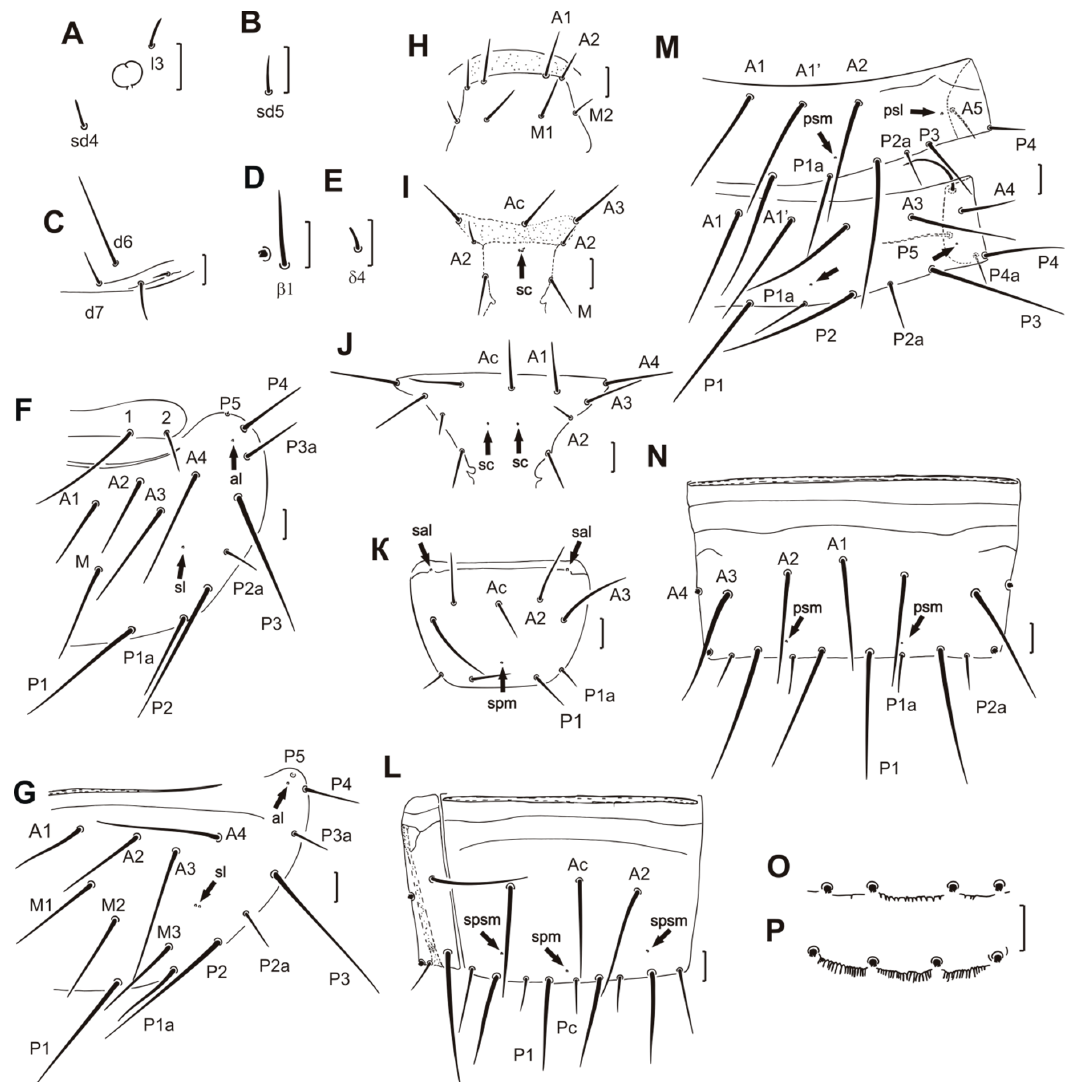
Figure 2. Mastodonentomon macleani (Nosek, 1977). ( A ) Pseudoculus with setae l3 and sd4 . ( B ) Cephalic seta sd 5. ( C ) Hind part of head. ( D ) Foretarsal seta β 1 . ( E ) Foretarsal seta γ 4 . ( F ) Pronotum and mesonotum, right side. ( G ) Metanotum, right side. ( H ) Anterior part of the prosternum. ( I ) Anterior part of the mesosternum. ( J ) Anterior part of the metasternum. ( K ) Sternite I. ( L ) Sternite VII. ( M ) Tergites I and II, right side. ( N ) Tergite VII. ( O ) Hind margin of tergite IX. ( P ) Hind margin of tergite X. Arrows indicate pores (sl = sublateral, psm = posterosubmedial, psl = posterosublateral, sc = sternal central, spm = sternal posteromedial, spsm = sternal posterosubmedial). Figures A–E, J: paratype. Figures F–I, K–P: holotype. Scale bars = 20 μ m.